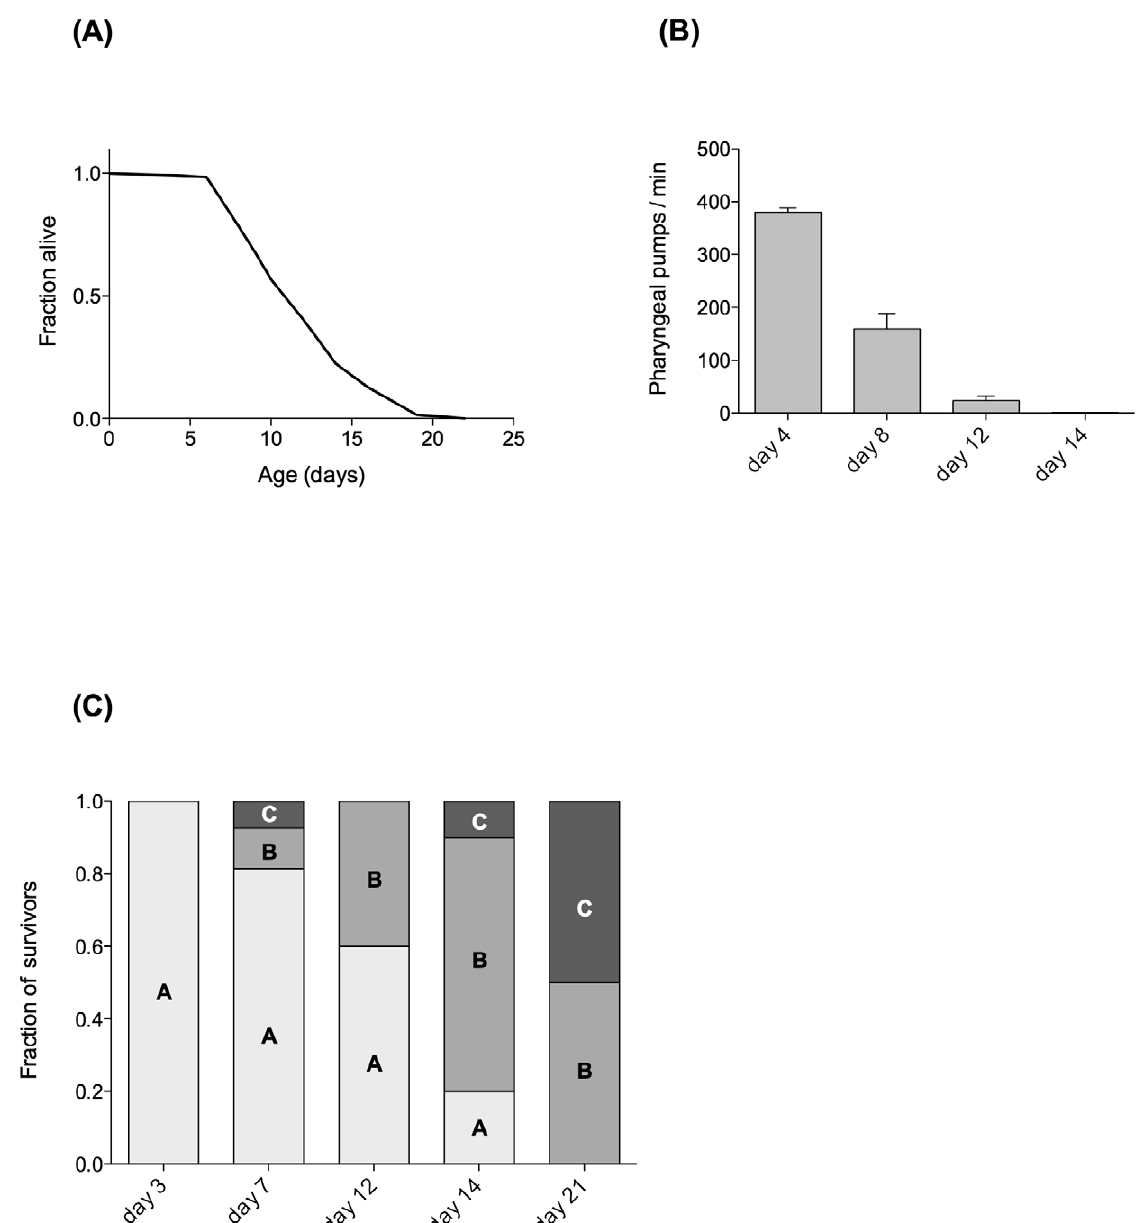
Figure 1. Age-dependent survival and functional decline in a typical JK1107 ( glp-1 ) C.elegans cohort. Nematodes are maintained at the restrictive temperature of 25.5 u C. ( A ) Survival curve. Mean lifespan 12.3 days (n=134). ( B ) Functional decline as judged by reduction in pharyngeal pumping rate (mean 6 SEM) with age. Worms exhibiting irregular or sporadic pumping were excluded. ( C ) Motility phenotype of surviving worms at different ages. Scoring was carried out according to [40]. Briefly, class ‘‘A’’ worms move vigorously, leaving sinusoidal tracks. Class ‘‘B’’ worms move only in response to touch or appear uncoordinated in locomotion. Class ‘‘C’’ worms cannot move their body but exhibit head and/or tail movements in response to